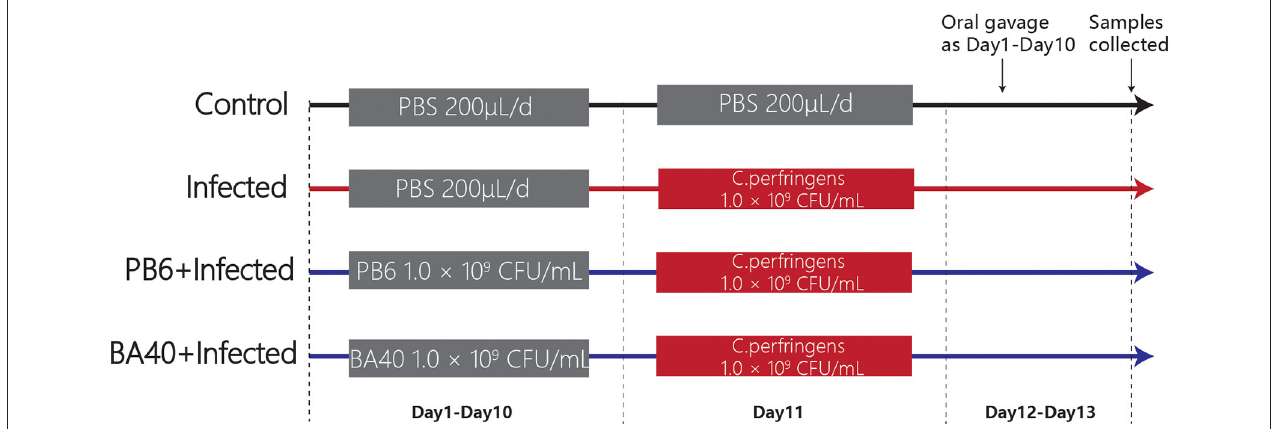
FIGURE 1 | Experimental design and scheme of the animal